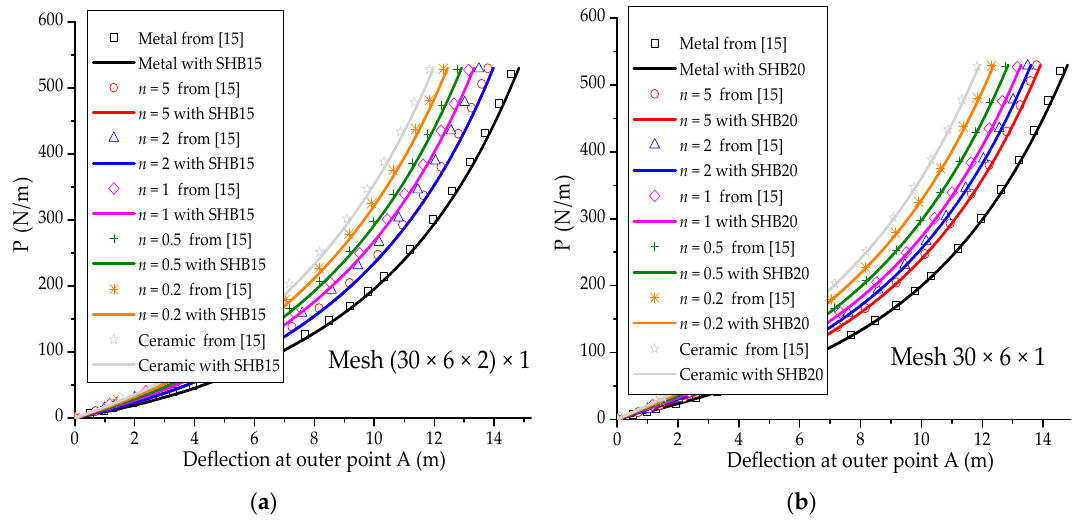
Figure 8. Load–deflection curves at the outer point A for the slit annular plate. ( a ) Prismatic SHB15 element; ( b ) hexahedral SHB20 element.